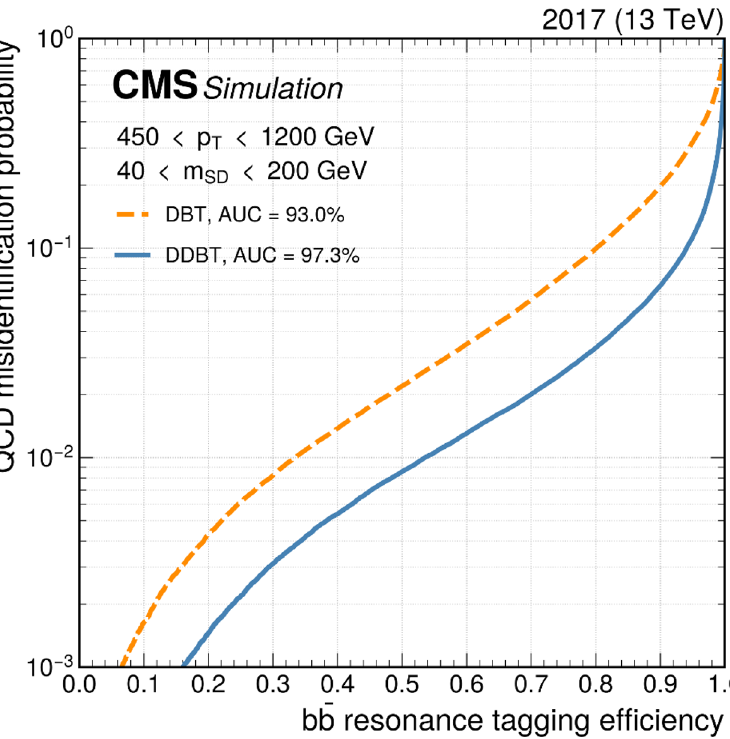
Figure 1 . The performance curves of misidentification probability for jets originating from QCD multijet production versus the identification probability for bb resonance jets for the DBT (orange dashed line) used in a prior CMS result and the DDBT (blue solid line). The bb resonances are generated with variable masses in the range 15–250 GeV. The curves are evaluated with simulation corresponding to the detector conditions in 2017. Jets are required to have p 1200 GeV and m in the range 40–200 GeV. The area under the curve (AUC) is reported as a SD performance metric for both